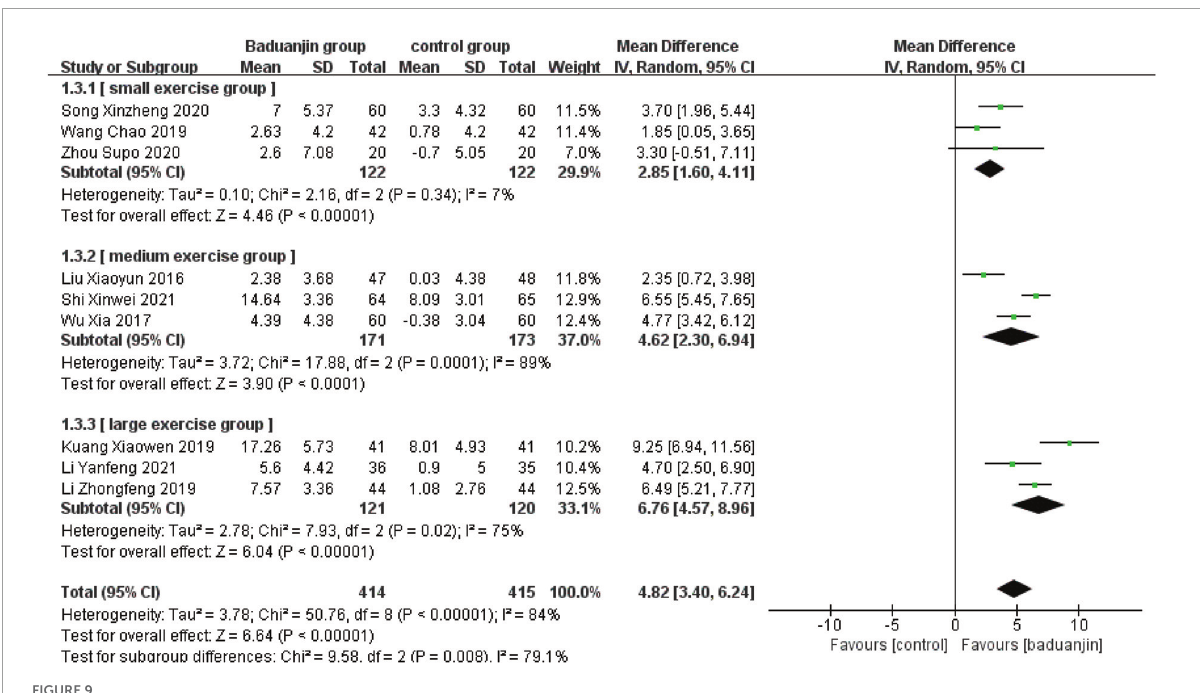
FIGURE9 Forest plot of the subgroup analysis of BBS for the total exercise amount. CI, confidence interval; SD, standard deviation.